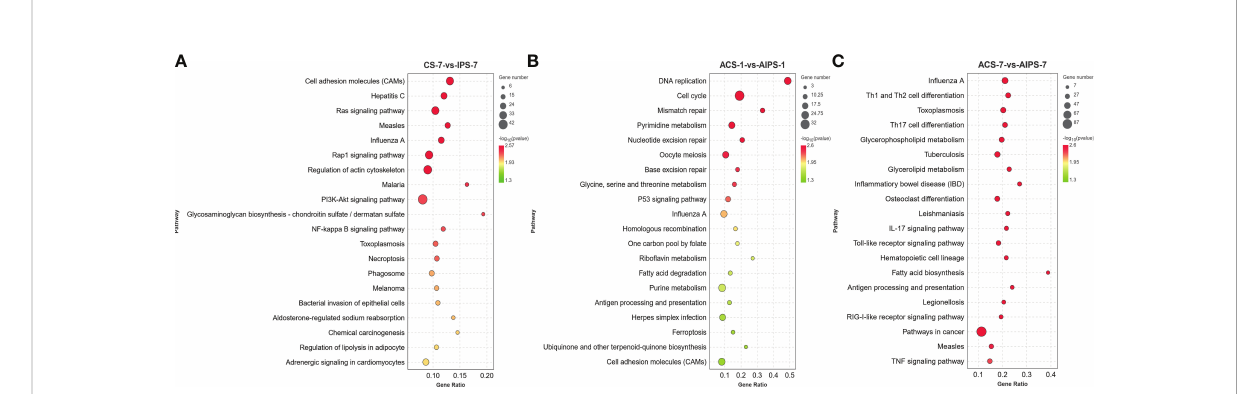
FIGURE 7 KEGG enrichment bubble plot of Top 20 pathways between PBS and inactivated vaccine groups at 7 th post immunization day (A) and 1 st (B) and 7 th (C) post challenge day ( p <